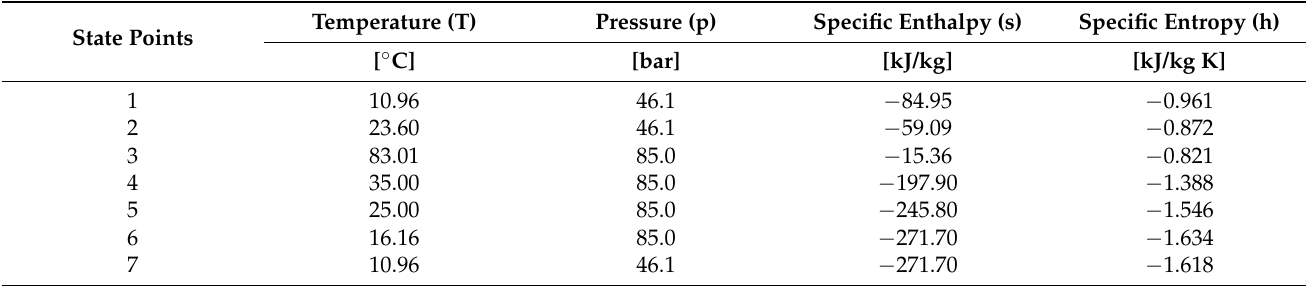
Table 4. Thermodynamic properties of the heat pump cycle in the basic operating